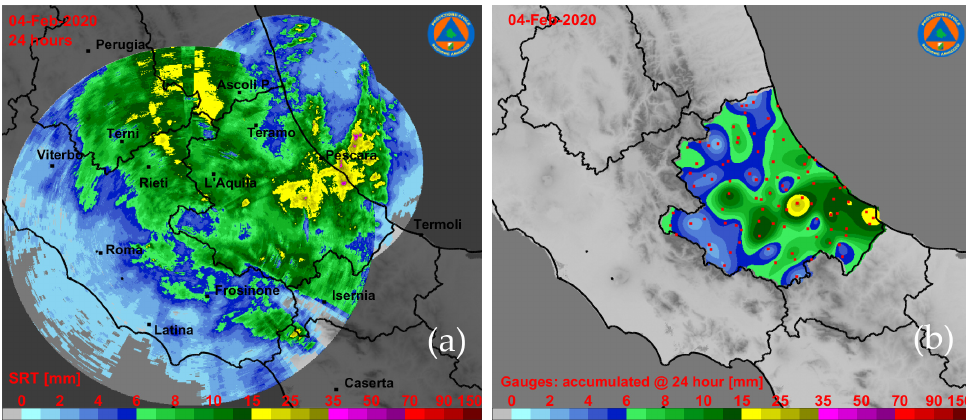
Figure 7. 24-h rainfall accumulated during the event occurring during 4 February, 2020: ( a ) radar composite domain and the ( b ) rain-gauge network within the Abruzzo region (see Figure 2).